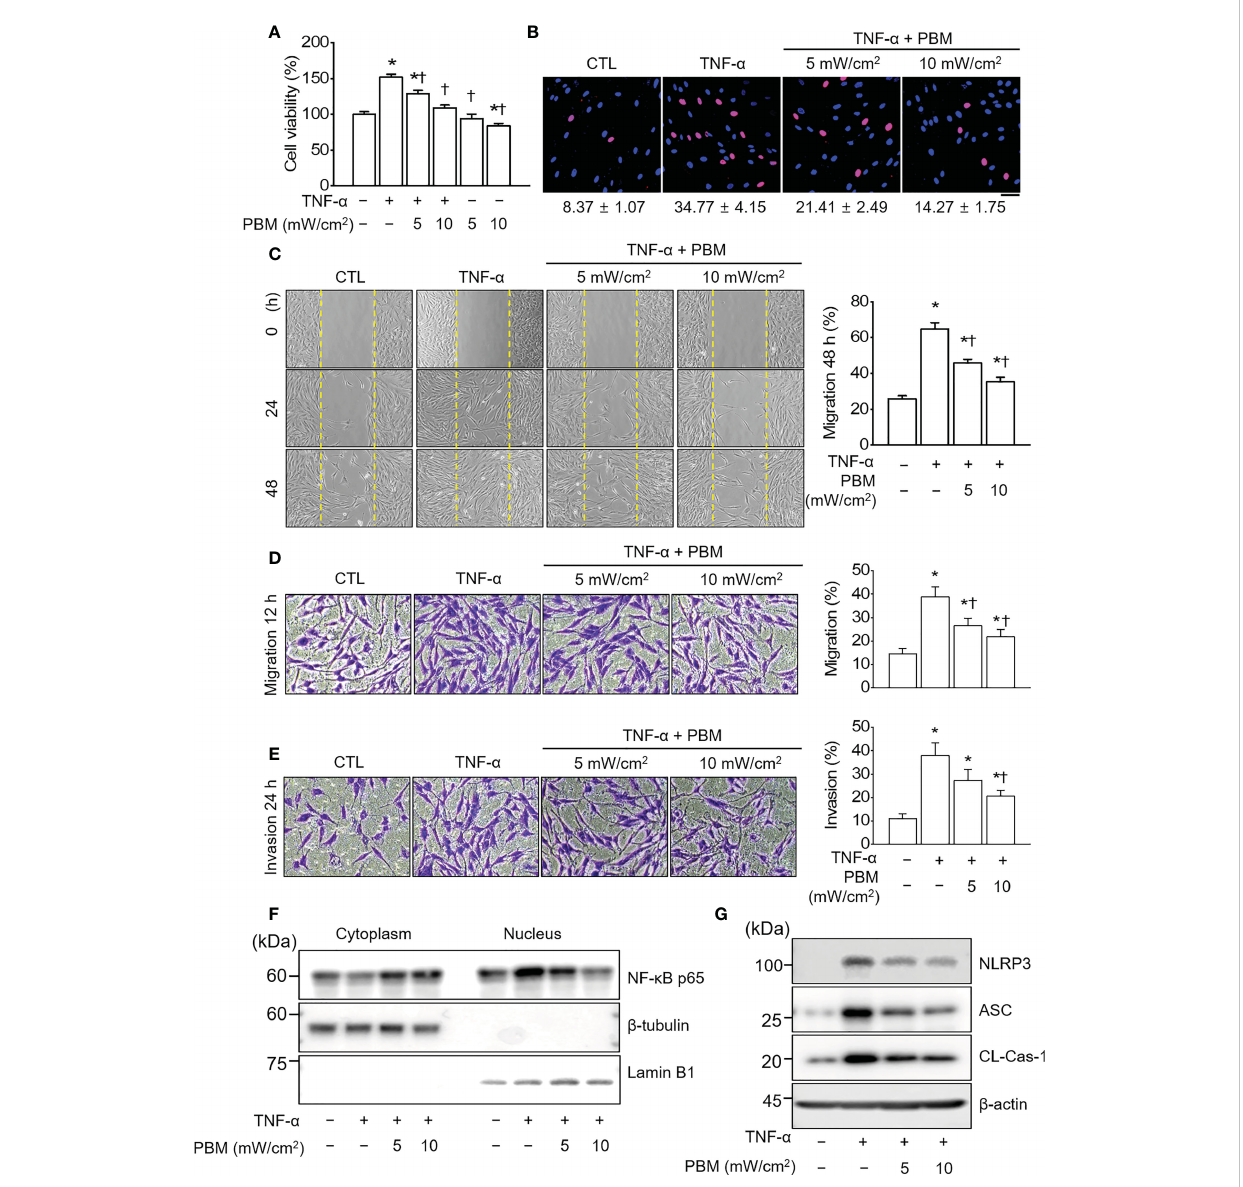
FIGURE 1 PBM suppresses TNF- a -induced proliferation, migration, and invasion in RA-FLSs. (A) Effect of PBM on RA-FLSs cell viability ( n = 4). Cells were exposed to 10 ng/mL of tumor necrosis factor (TNF)- a and/or PBM at 610 nm wavelength for 20 min with power intensities of 5 and 10 mW/cm 2 . After 24 h, cell viability was measured by 3-(4,5-dimethylthiazole-2-yl)-2,5-diphenyl tetrazolium bromide (MTT) assay as described in the Materials and Methods 2.2. (B) RA-FLSs were treated with 10 ng/mL of TNF- a and/or PBM at 610 nm wavelength for 20 min with power intensities of 5 and 10 mW/cm 2 ( n = 3). After 24 h, 5 ‐ Bromo ‐ 2 ′ ‐ deoxyuridine (BrdU) immuno fl uorescence staining was performed as described in the Materials and Methods 2.3. Immunocytochemistry showed localization of BrdU-labeled nuclear (red) and nuclear staining (blue). Bar graphs represent the quanti fi cation of BrdU-positive cells. Scale bar, 30 m m. (C) Representative phase-contrast images at 0, 24, and 48 h showing the migration of RA- FLSs into the cell-free gap left by the removal of the Culture-Insert ( n = 3). Bar graphs represent the percentage of migrated cells 48 h after PBM treatment. (D) Representative microscopic images of migrating cells by transwell migration assays ( n = 3). (E) Representative microscopic images of invasive cells by transwell system ( n = 3). (F) Detection of NF- k B p65 in cytoplasmic and nuclear fractions. Cell lysates were fractionated into nucleus and cytoplasm components ( n = 2). Nucleus fraction was con fi rmed by expression of lamin B1, a nuclear structural protein, and the absence of expression of b -tubulin. (G) Detection of NLRP3 in fl ammasome ( n = 3). Data are shown as the mean ± SE. * p < 0.05, compared to CTL. † p < 0.05, compared to TNF- a